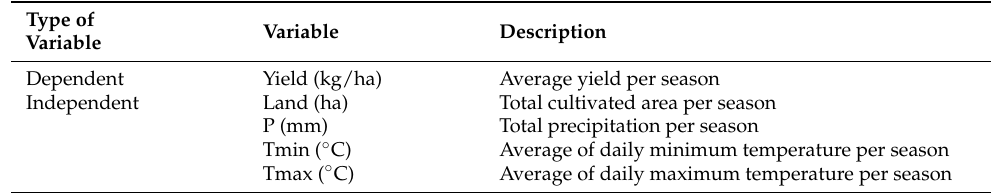
Table 2. Variable